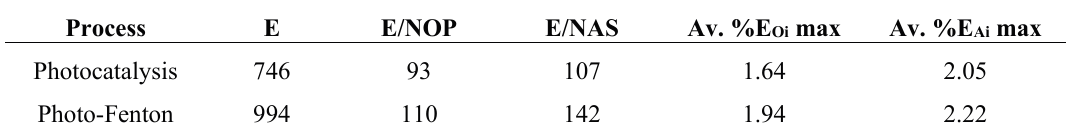
Table 11. Summarized final basic parameters for the environmental comparison of the